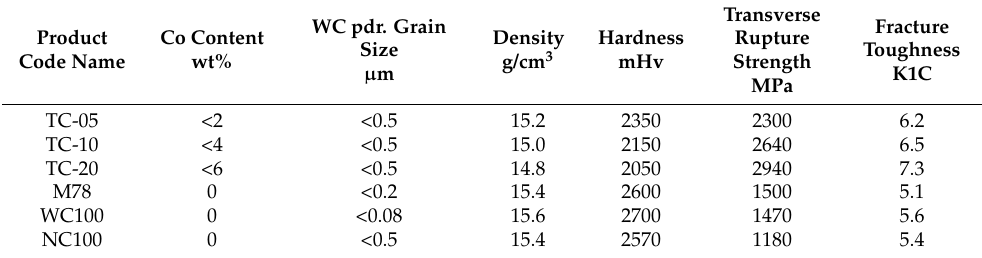
Table 4. Typical mechanical properties of Fine WC/Co hard alloys sintered by